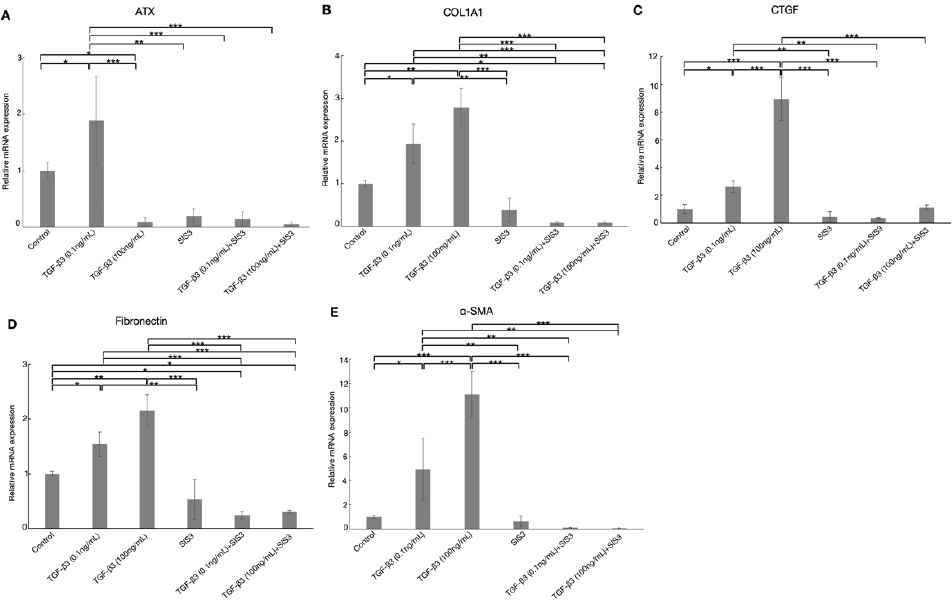
Figure 4. Real-time qPCR analysis of ( A ) ATX, ( B ) COL1A1, ( C ) CTGF, ( D ) fibronectin, and ( E ) α - SMA mRNA expression after treatment by TGF- β3 with or without the Smad3 inhibitor, SIS3, in HTM cells. The relative mRNA expression level of ATX was significantly upregulated by 0.1 ng/mL TGF- β3 and suppressed with SIS3 cotreatment. The level of ATX was significantly decreased by 100 ng/mL TGF- β3 treatment, but did not change after cotreatment with SIS3. The relative expression levels of COL1A1, CTGF, fibronectin, and α -SMA mRNA were significantly increased following treatment with 0.1 and 100 ng/mL TGF- β3 compared with the controls, but these enhancements were significantly decreased by cotreatment with SIS3. GAPDH was used as an internal control for normalization. Data are presented as the mean ± standard deviation. * p < 0.05, ** p < 0.01, *** p < 0.001, n = 5.